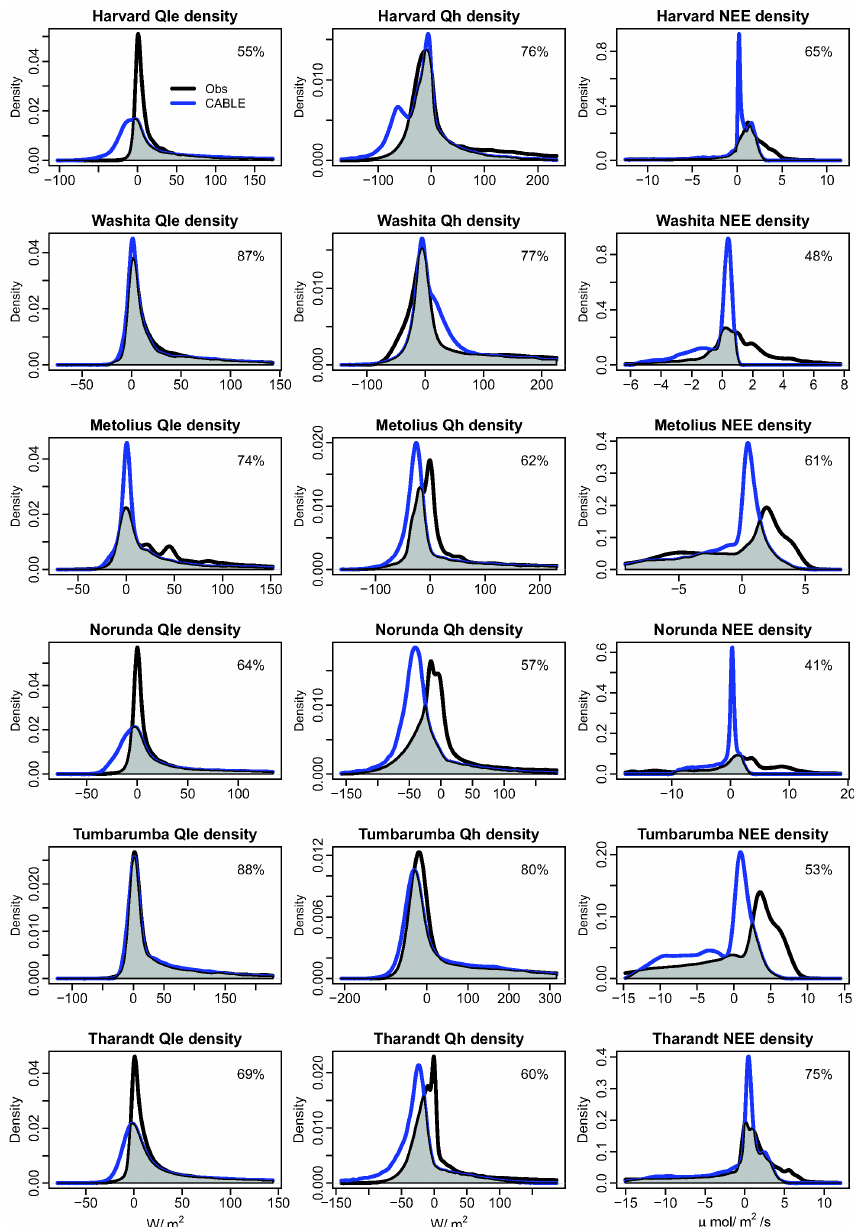
Fig. 2. Probability density functions, based on daily data, for the six locations detailed in Table 1. The first column is the latent heat flux (Wm − 2 ), the second column is the sensible heat flux (Wm − 2 ), and the third column is the net ecosystem exchange (µmolm − 2 s − 1 ). The grey shaded region on each panel shows the region of overlap and this is quantified by the numeric value